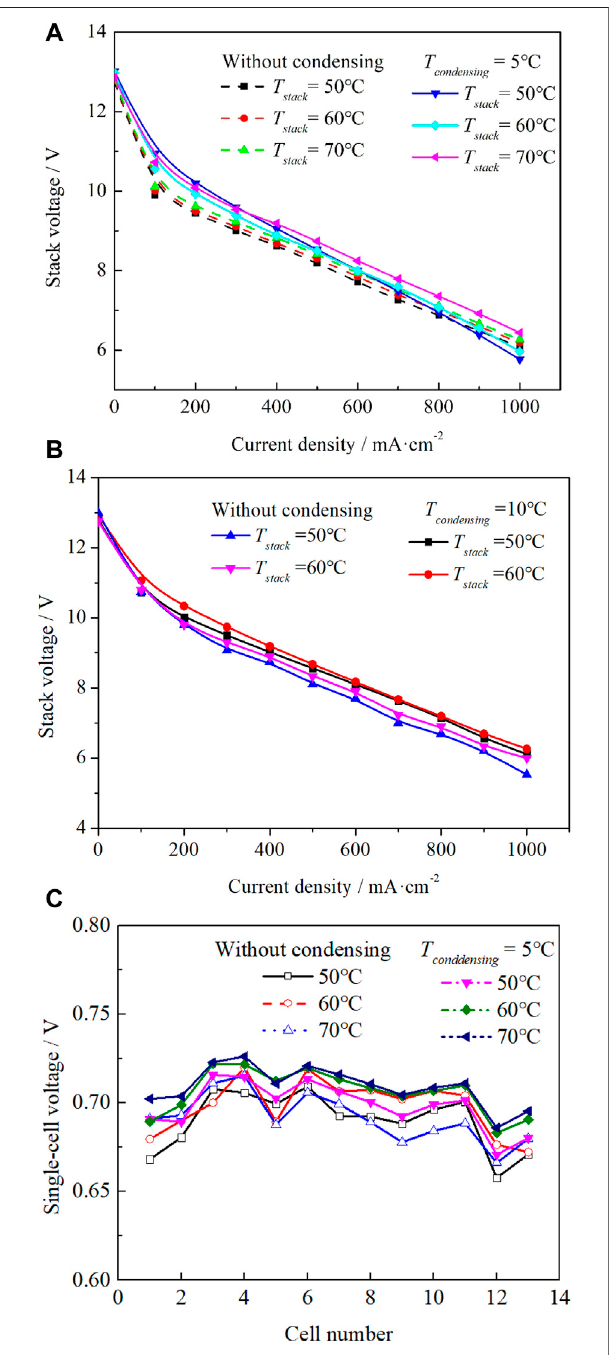
FIGURE 3 | Performance comparison. (A) and (B) Stack voltage at different condensing temperature and without condensing, (C) Voltage distribution.